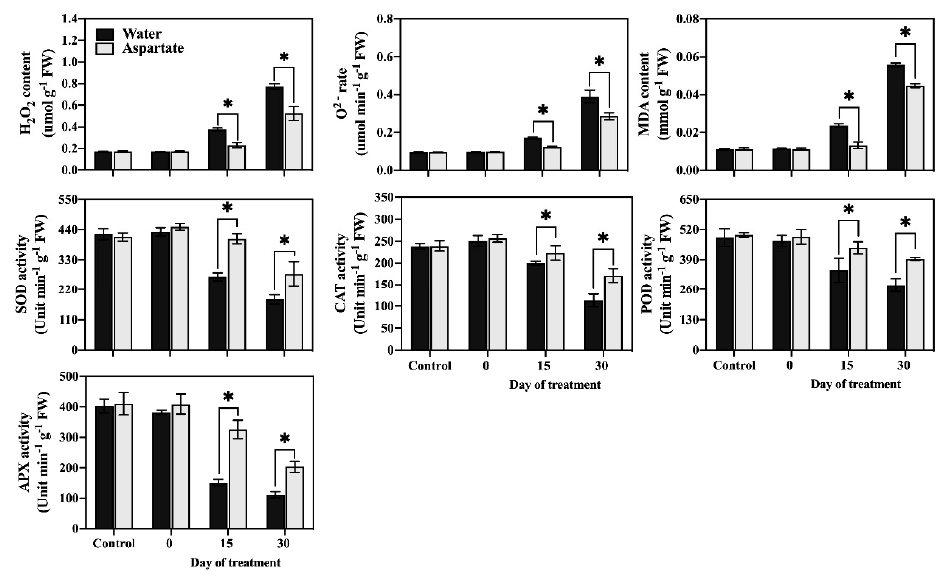
Figure 2. Effects of exogenous application of aspartate (Asp, 2 mM) on hydrogen peroxide (H 2 O 2 ) content, superoxide (O 2 − ) production rate, malondialdehyde (MDA) content, and enzymatic activity of superoxide dismutase (SOD), catalase (CAT), peroxidase (POD), and ascorbate peroxidase (APX) in leaves of perennial ryegrass under control temperature and heat stress. Vertical bars over the column represent standard errors of a given data point, and * represents significant differences between water and Asp under control temperature and at a given day of heat stress treatment based on the LSD test at p =